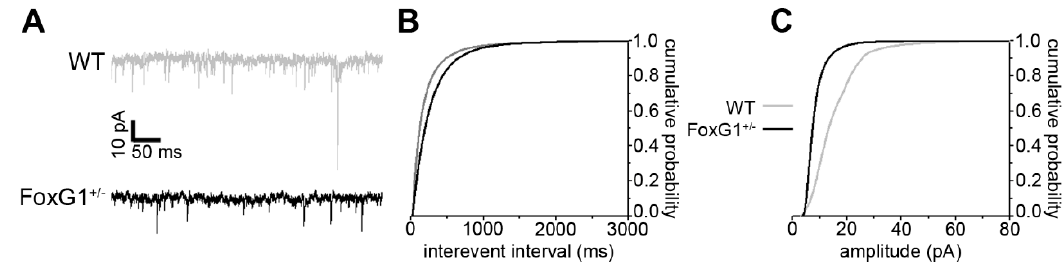
Figure 4. Downregulated spontaneous excitatory neurotransmission in the cortex of FoxG1 +/ − mice. ( A ) Representative traces from mEPSC recordings from wild type (WT) and FoxG1 +/ − mice; ( B ) cumulative distributions of interevent intervals showing lower mEPSC frequency in FoxG1 +/ − mice compared to WT controls (WT, n = 9; FoxG1 +/ − , n = 9; Kolmogorov–Smirnov test, p < 0.001); ( C ) cumulative distributions of event amplitudes showing reduced mEPSC frequency in FoxG1 +/ − mice compared to WT controls (WT, n = 9; FoxG1 +/ − , n = 9; Kolmogorov–Smirnov test, p < 0.001).